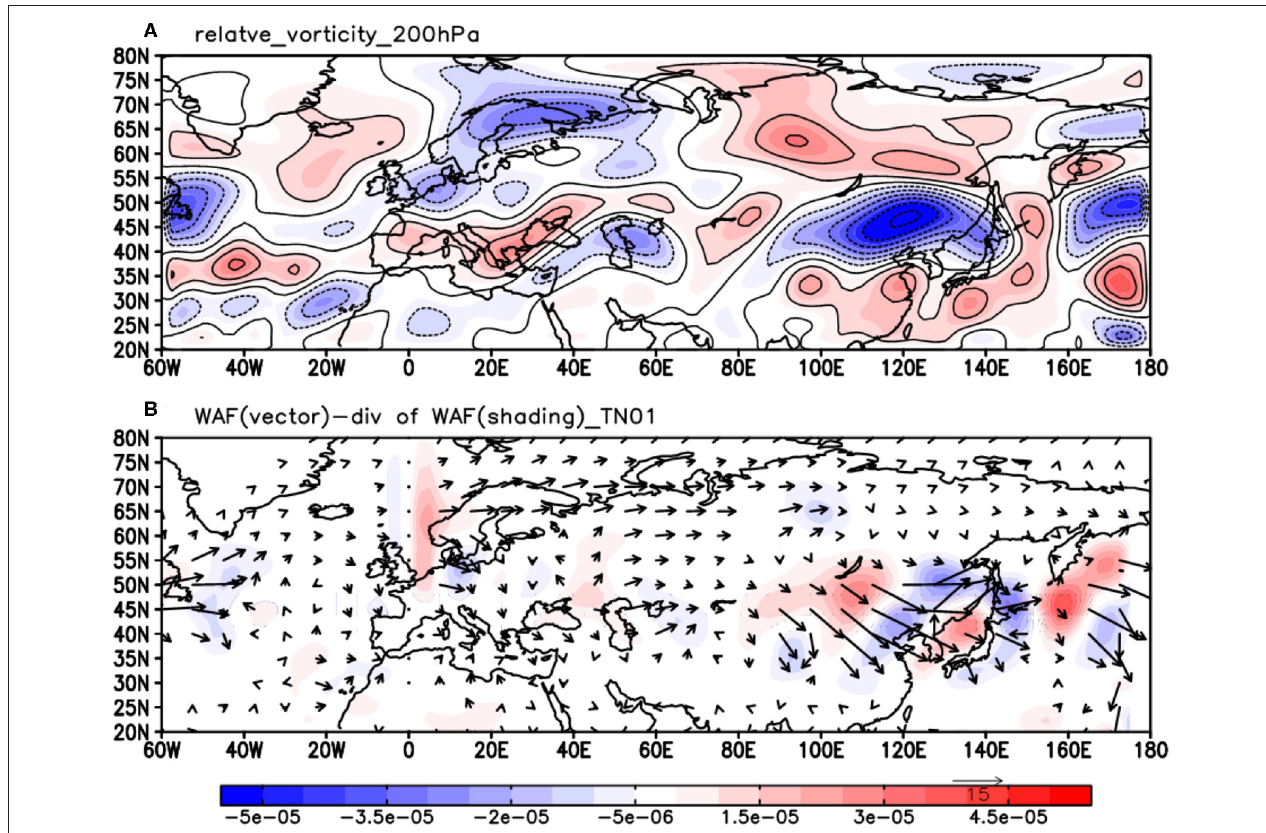
FIGURE 8 | (A) The distribution of anomalous vorticity (shaded; s − 1 ); (B) wave activity fluxes (vector; m 2 .s − 2 ) and divergence of wave activity fluxes (shaded; m.s − 2 ); both were averaged between 18 July and 05 Auguest at 200 hPa.